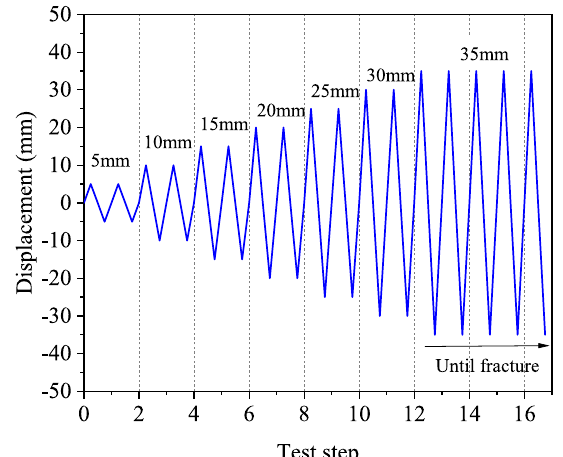
Fig. 7 Loading protocol for USS